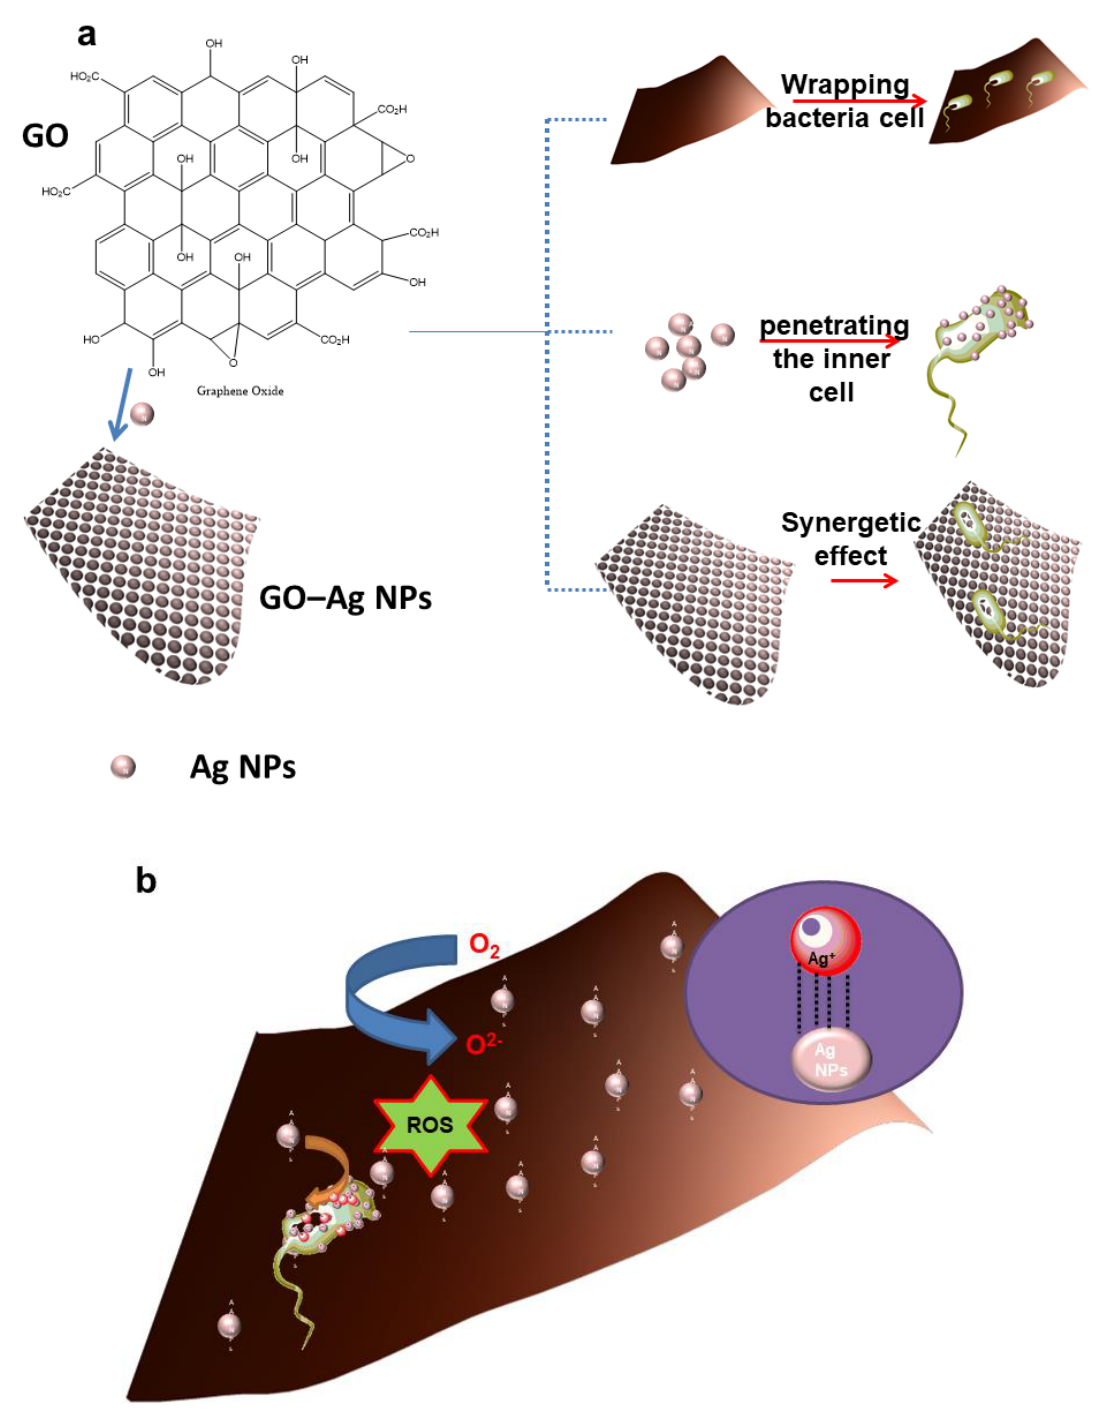
Figure 10. Physical attack by bacteria of Ag, GO and GO–Ag NPs ( a ) and ROS inducement as one of the important factors for the bactericidal e ff ect of GO–Ag NPs ( b